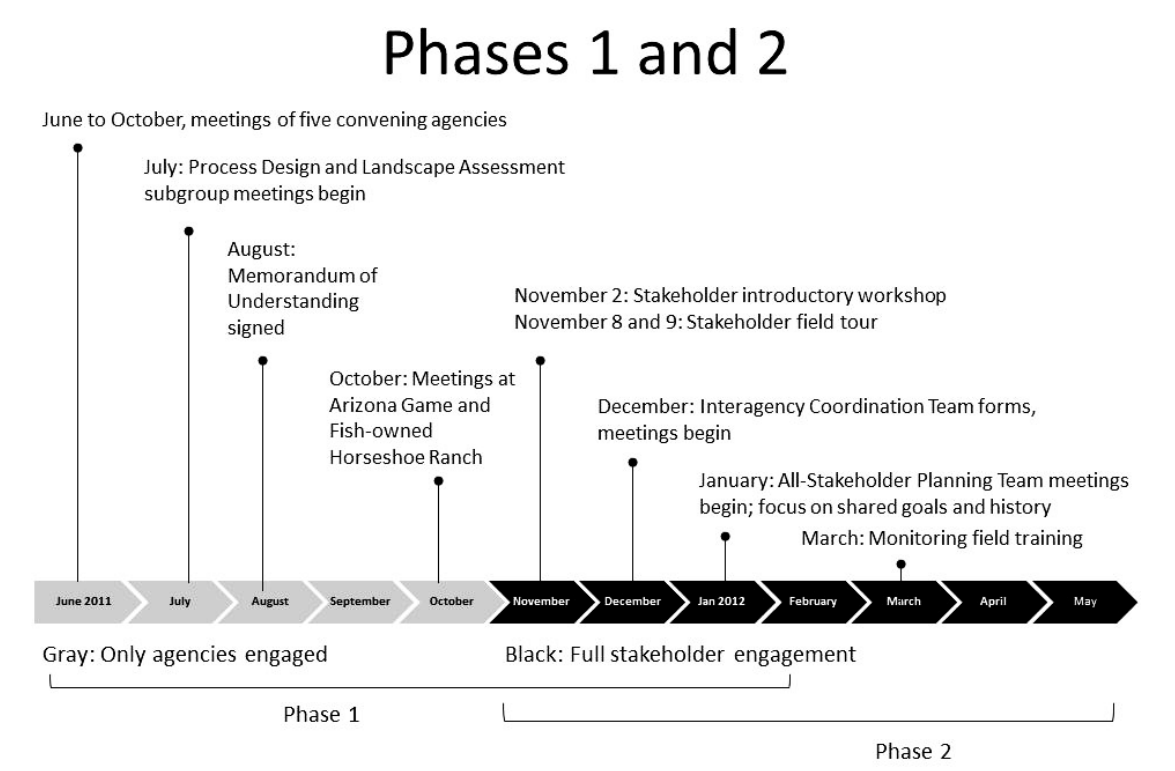
Fig. 2 . Timeline, April 2011 to March